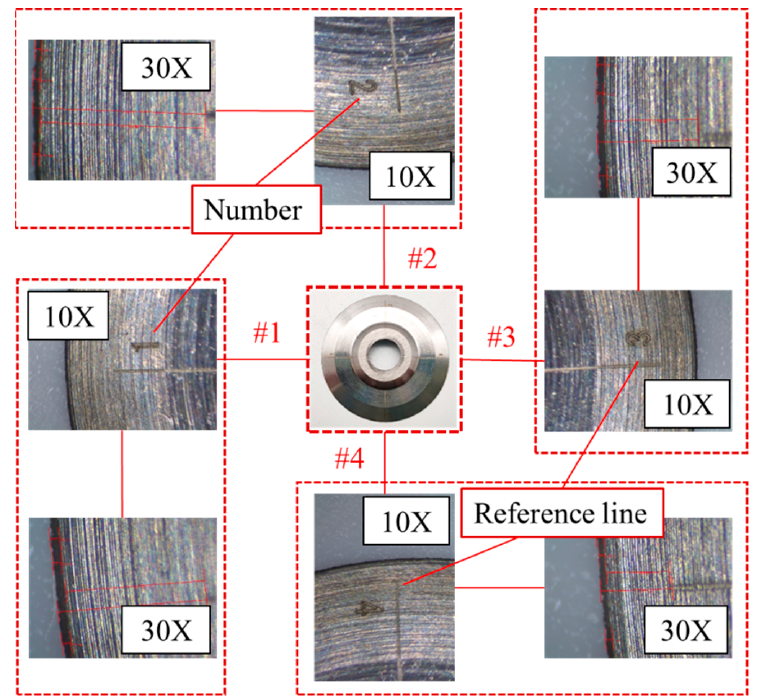
Figure 5. The wear observation method of the disc